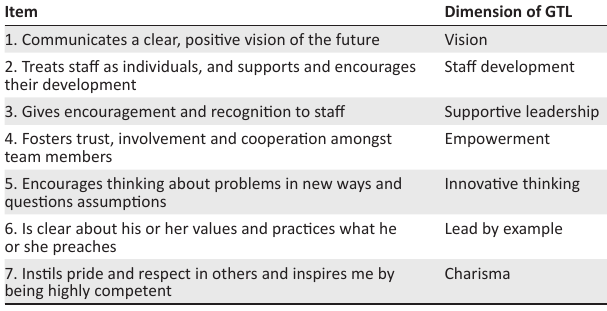
TABLE 1: Dimensions of Global Transformational